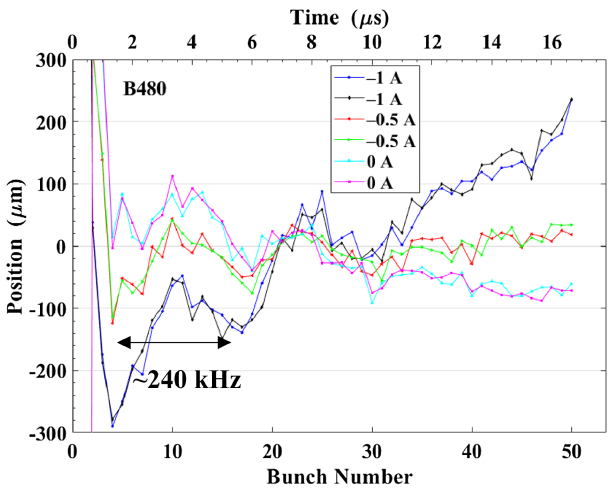
FIG. 8. Examples of the variation with V125 corrector current of the beam vertical centroids bunch by bunch for 50 micropulses and 300-shot averages at B480 (64.0 m downstream of B418). The ∼ 240 kHz centroid oscillation amplitude is observed to be larger for the − 1 A ( − 2 mrad) steering in